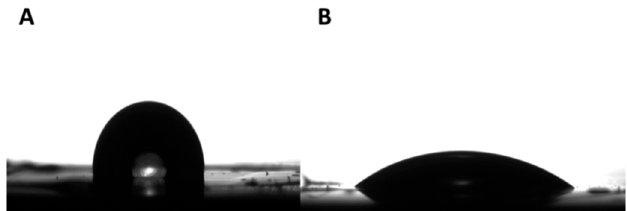
Figure 10. Water contact angle of block copolymer brush thin films prepared from pure THF ( A ) or THF/water ( B ).